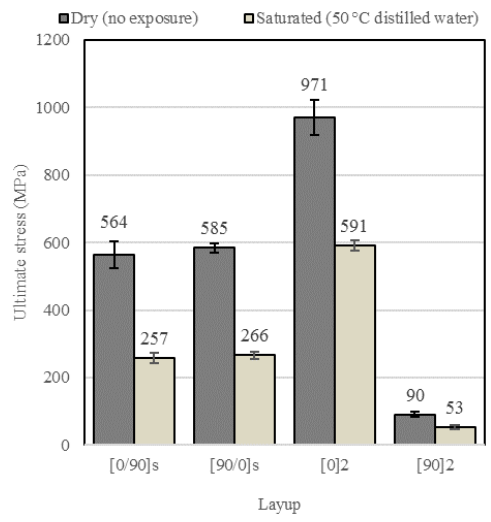
Figure 2. Coupon layout geometry and sensor layout (a) . Experi- mental test setup (b) . Figure 3. Average ultimate stresses of dry and saturated samples.